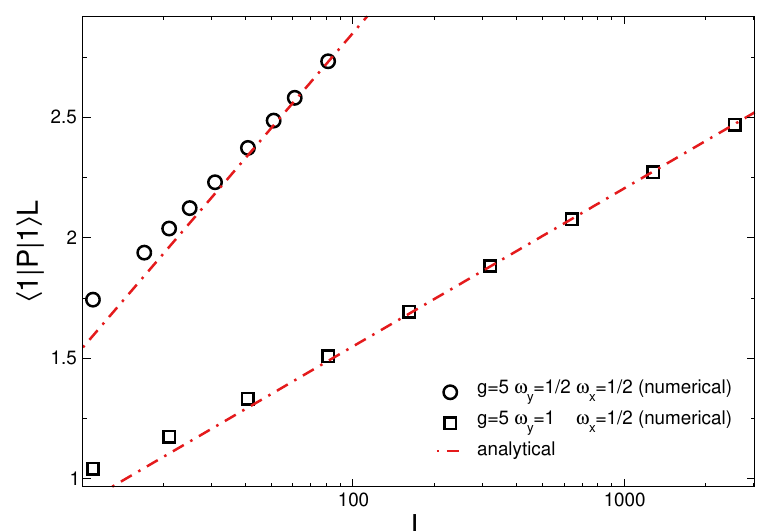
Figure 4: Rescaled flat-vector expectation value 〈 1 | (cid:80) | 1 〉 L of the momentum operator in the ordered phase of the QSM. We show data for several bipartitions with aspect < 1 the boundary between the two subsystems is ratios ω , ω (see Fig. 1). For ω x y y not smooth (see Fig. 1 (b)). Symbols are exact numerical results. The dashed-dotted lines are analytic predictions from (43) and